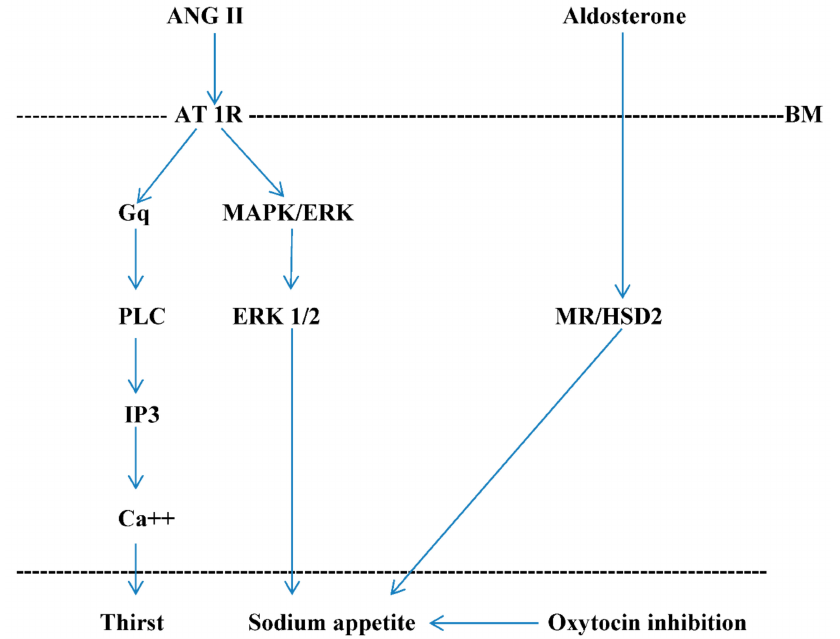
Figure 1. Cellular signaling pathways involved in sodium appetite. AT 1R signaling triggers the intracytoplasmatic production of the inositol 1,4,5-triphosphate (IP3) that enhances Ca++ mobilization and the extracellular regulated kinase 1 and 2 (ERK 1 and 2). Thus, IP3 stimulates thirst, while ERK 1 and 2 stimulates sodium appetite. Aldosterone induces sodium appetite, possess non-genomic and genomic effects on mineralcorticoid receptor (MR), and acts by the enzyme 11 β -hydroxysteroid dehydrogenase type 2 (HSD2) that is co-localized with MR. Non-genomic MR effect induces a possible cytoplasmic crosstalk with ERK 1 and 2. Furthermore, aldosterone stimulates sodium appetite via inhibition of the responsiveness of PVN oxytocinergic neurons to ANG II. AT 1R: ANG II type 1 receptor—Gq: Gq protein α subunit—PLC: phospholipase C—MAPK: mitogen-activated protein kinase—BM: basal membrane of angiotensinergic and mineralcorticoid-sensitive